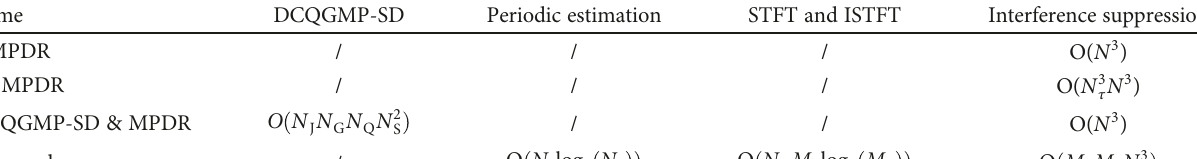
Table 2: Computation complexities of the proposed method and the compared methods.